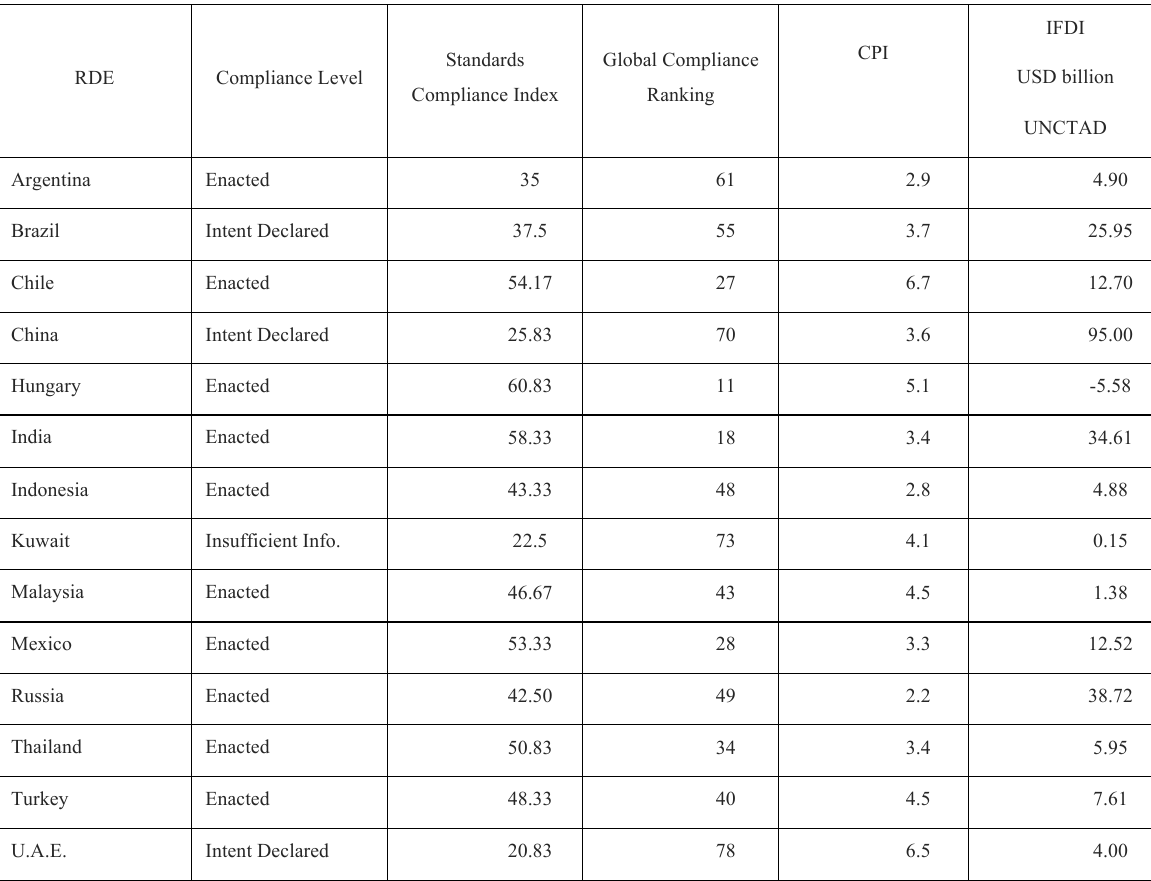
Figure I: Conceptual Matrix of the influence of corruption on Corporate Governance Standards